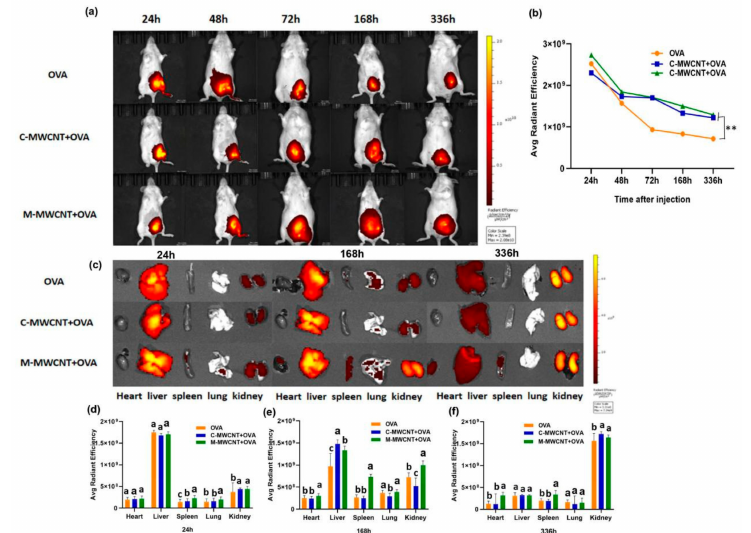
Figure 10. Living animal imaging on ICR mice. The OVA was labeled using a Cy5.5 fluorescent dye, and the mice were immunized with M-MWCNT+OVA, C-MWCNT+OVA, or OVA. The living animal imaging and fluorescence intensities in the mice at 24, 48, 72, 168, and 336 h after injection was detected by an in vivo optical imaging system ( a , b ), ** p < 0.01. Direct imaging and fluorescence intensities of the spleen, liver, heart, kidney, and lung of injected mice were detected on 24, 168, and 336 h after injection ( c – f ). Different letters (a–c) above each group of bars indicate statistically significant differences ( p <